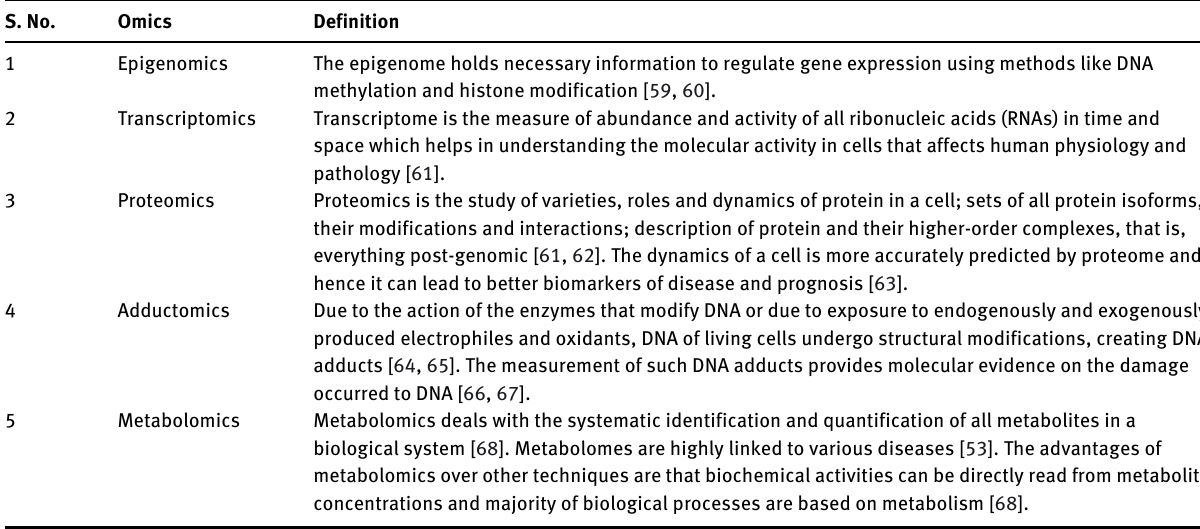
Table 1: Omics and its feature in PoC. S.